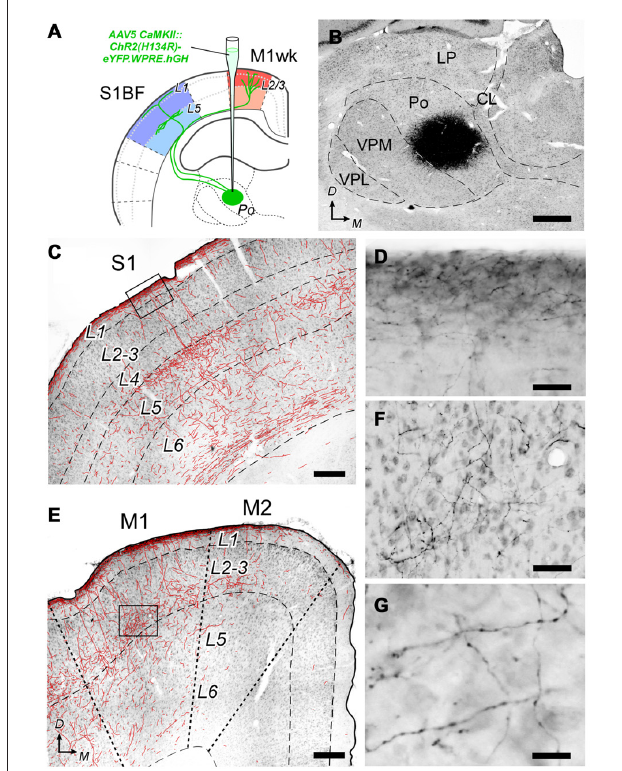
FIGURE 5 | Histological verification of the AAV5 CaMKII::ChR2(H134R) -eYFP.WPRE.hGH vector expression specificity. (A) Diagram summarizing the experimental procedure. A suspension of vector particles was stereotaxically injected in Po to drive ChR2 + eYFP expression in a population of the thalamocortical cells innervating M1wk and S1BF. (B) The center of a representative vector injection site is shown on a coronal section of the thalamus (the complete series of sections containing the transfected cell somata is illustrated in Supplementary Figure S2 ). Nickel-enhanced glucose-oxidase immunohistochemistry against eYFP, and light thionin counterstain. Note the “halo” of labeled dendrites radiating around the dense core region that contains the transfected cell bodies. (C) Coronal section of the cerebral cortex in S1 showing the distribution of transfected Po axons. To increase axon visibility at this magnification, a camera-lucida line drawing of the axons is overlaid on the image. (D) High-magnification detail of labeled axons in L1 of S1 (inset in panel C ). (E) Axonal labeling in the motor cortex. Conventions as in panel (C) . (F) High-magnification detail of axons labeled in L3 of M1 (inset in panel E ). (G) Axonal varicosities, suggestive of synaptic boutons in L3 of M1. Bars: B = 500 µ m; C,E = 250 µ m; D,F = 50 µ m; G = 15 µ m. Others abbreviations: CL, Central lateral thalamic nucleus; LP, Lateral posterior thalamic nucleus; VPL, Ventral posterolateral thalamic